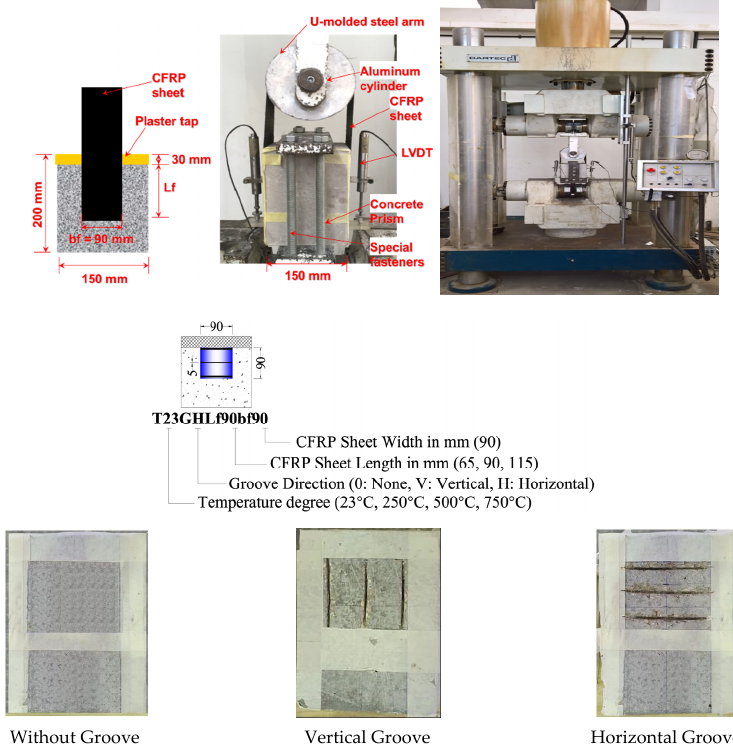
Figure 1. Specimen layout and test setup. Table 2. Mixture proportions of the concrete.